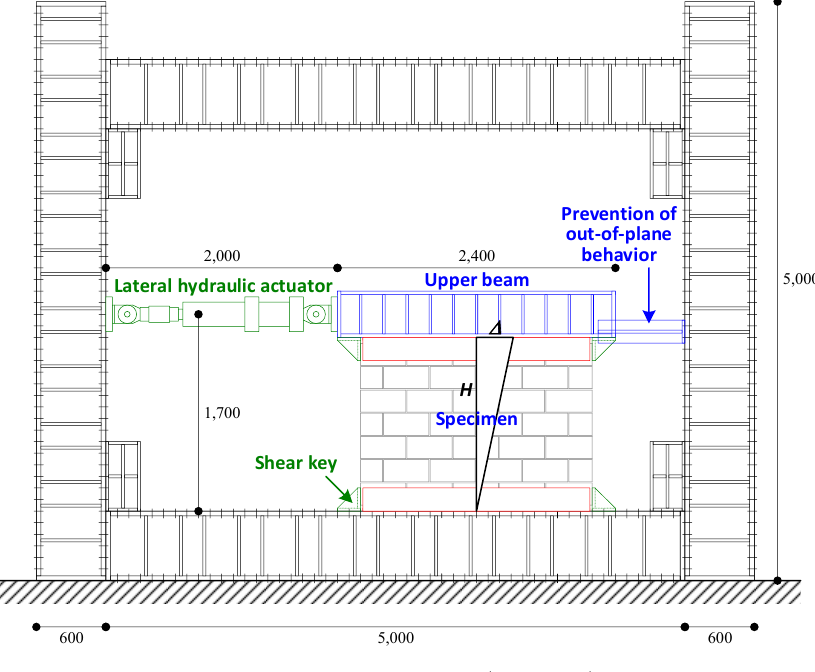
Figure 5. Loading system (unit: